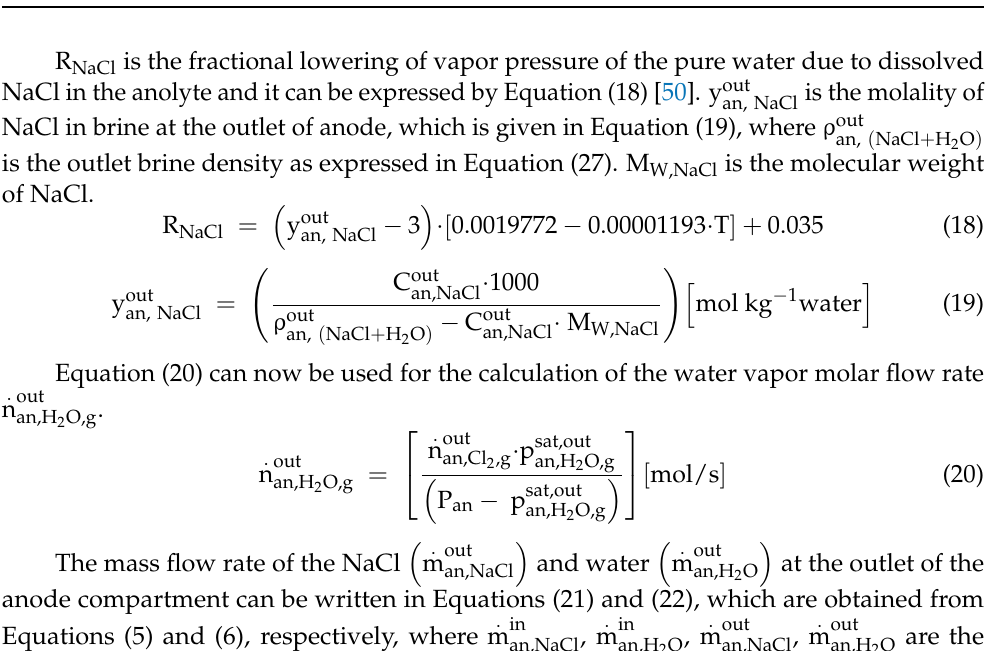
Table 1. Parameters for the Antoine equation, valid in the temperature range 0 to 100 ◦ C [34]. Parameter Value b 7.95190 d 1659.793 e